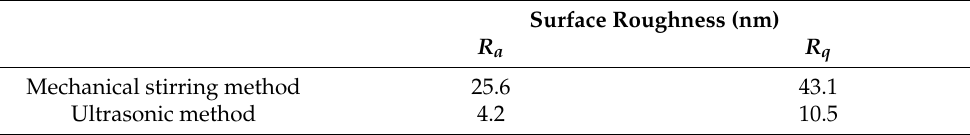
Table 1. The surface roughness of nano-ZnO by mechanical stirring and ultrasonic